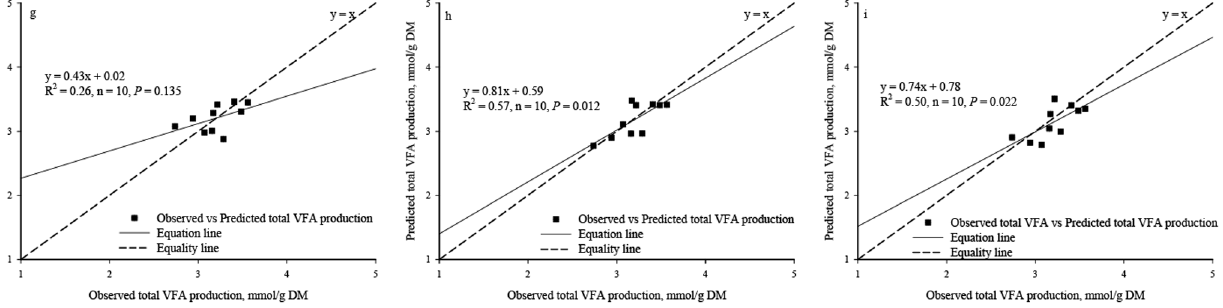
Fig. 5. Relationship between the observed vs. the predicted total VFA production. ( g . Predicted values were from Equation III; h . Predicted values were from BP3 model where total VFA production using as individual output; i . Predicted values were from BP3 model where total VFA production was output